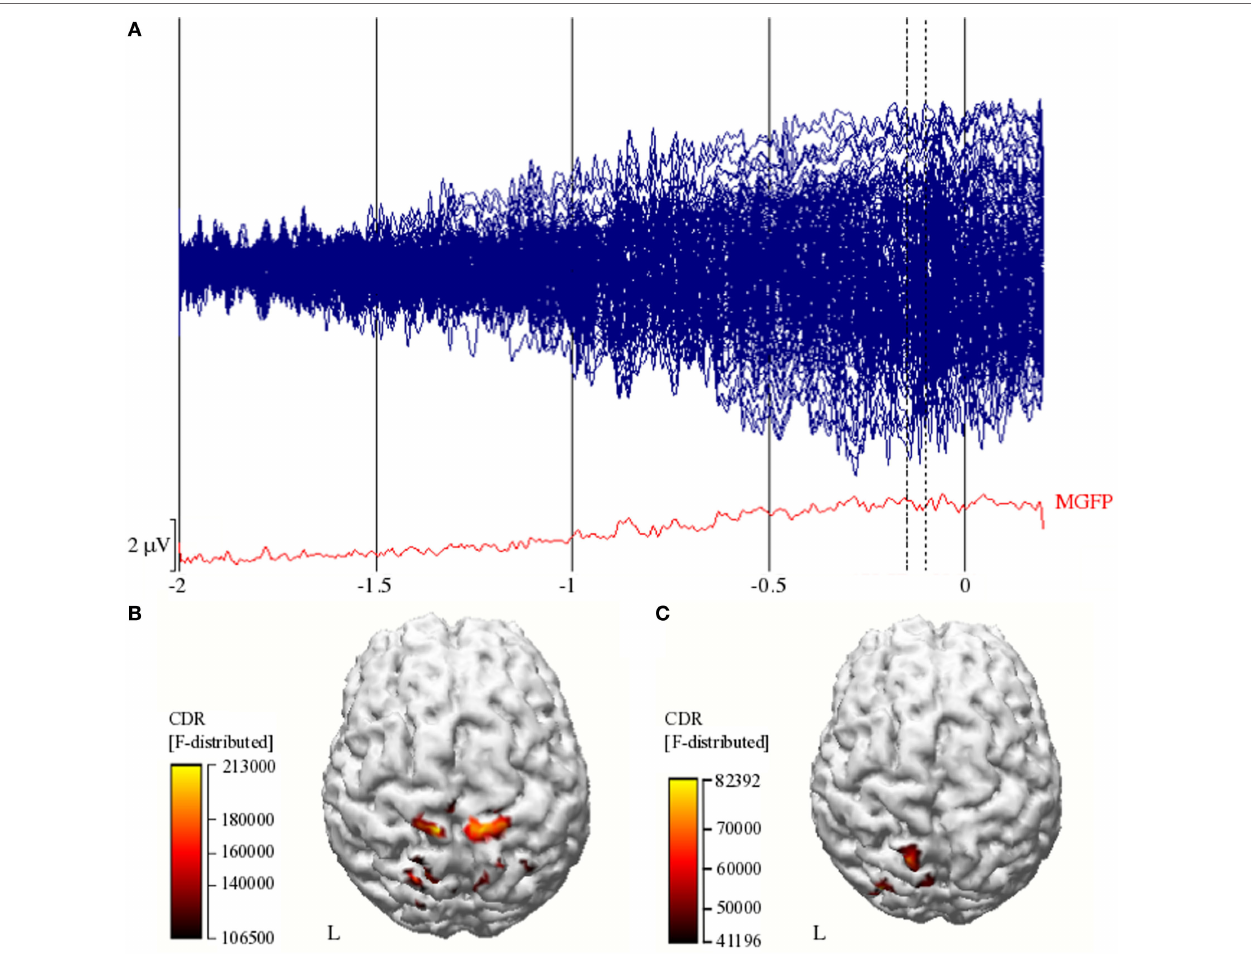
FigUre 2 | (a) Ensemble-averaged EEG of the 160 channels (blue butterfly plot) and Mean Global Field Power (MGFP; red line) from − 2 s to + 0.2 s (0 = EMG onset). Vertical dashed lines represent the start and end of the window of interest ( − 150 to − 100 ms). A scale bar is included in the lower left; (B) reconstructed cortical activity between − 150 and − 100 ms prior to movement onset for Subject 1 during hand opening pre-intervention, and (c) post-intervention. Color bars indicate the current density reconstruction (CDR) statistic from sLORETA. Left hemisphere is the lesioned